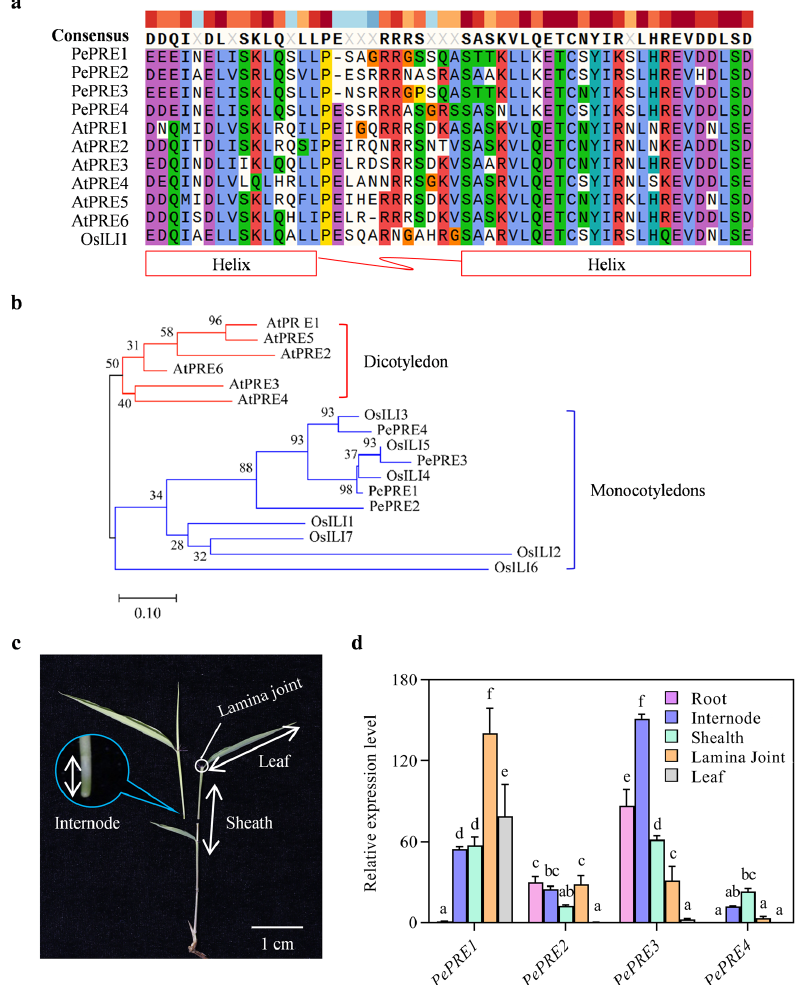
Figure 1. PePRE s in moso bamboo. ( a ) Sequences alignment of PRE proteins. Identical or similar amino acid residues are indicated by colorful shading and the helix and loop domains are highlighted. ( b ) Phylogenetic analysis of PRE proteins from rice and Arabidopsis . Full amino acid sequences were used. Bootstrap values of 1000 replications were shown. Pe, Phyllostachys edulis ; Os , Oryza sativa ; At , Arabidopsis thaliana . ( c ) The tissue of the aerial part of moso bamboo seedling. Scale bar represents 1 cm. ( d ) Expression level of PePRE s in di ff erent tissues of 3-week-old seedlings by qRT-PCR analysis. Di ff erent le tt ers above the data columns indicate signi fi cant di ff erences ( p < 0.05; Duncan’s test).